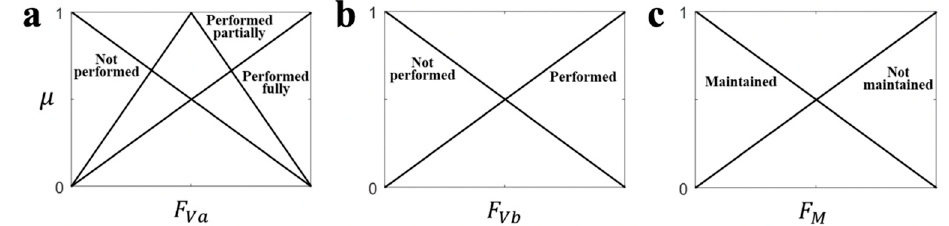
Figure 1. The membership functions for each type of feature. ( a ) F Va , ( b ) F Vb , ( c ) F M . The logic rules AND/OR were formulated by the minimum/maximum functions. The AND operation was applied for the truncate (implication) of S , and the maximum function was used for aggregation operation [30]. The result of the designed FIS, continuous FM scale, was provided as a constant value by using centroid defuzzification process [30,31]. The continuous FM scale scoring algorithm through FIS using the data acquired by the sensor is represented as shown in Figure 2.